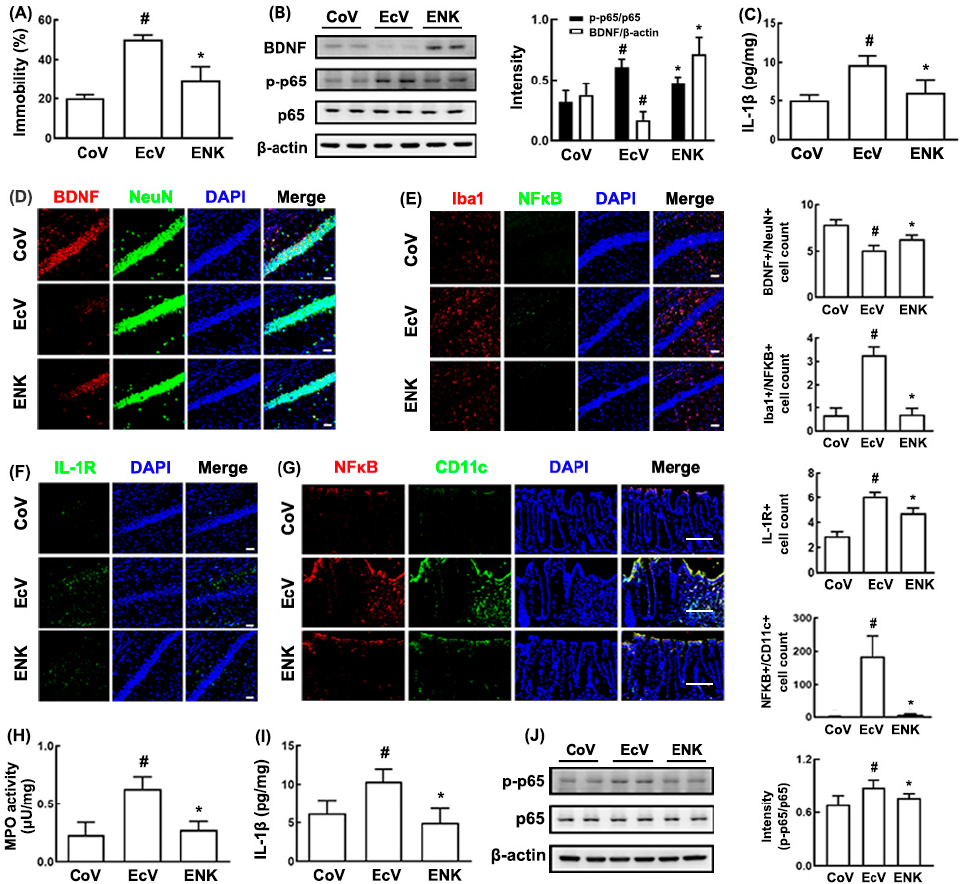
Figure 2. Effect of NK109 on the Escherichia coli K1-induced cognitive impairment and colitis in the germ-free mice. ( A ) Effect on the immobility time in the tail suspension test (TST). ( B ) Effect on the brain-derived neurotropic factor (BDNF) expression and NF- κ B activation in the hippocampus. ( C ) Effect on the IL-1 β level in the hippocampus. Effects on the BDNF + /neuronal nuclei (NeuN) + ( D ), NF- κ B + /Iba1 + ( E ), and IL-1R + cell ( F ) populations in the hippocampus. Effect on the myeloperoxidase (MPO) activity ( G ), IL-1 β expression ( H ), the NF- κ B + /CD11c + cell population ( I ), and NF- κ B activation ( J ) in the colon. Escherichia coli K1-treated (EcV) and K1/NK109-treated (ENK) groups were exposed to K1 (1 × 10 9 CFUs/mouse/day) daily for 5 days and thereafter treated with NK109 (for ENK, 1 × 10 9 CFUs/mouse/day) or the vehicle (for EcV) for 5 days. The control group (CoV) was treated with saline instead of K1 and NK109. Data values were are as mean ± SD ( n = 4). # p < 0.05 vs. CoV. * p < 0.05 vs. EcV. Dapi, 4 ′ , 6-diamidino-2-phenylindole dihydrochloride; Iba1, ionized calcium-binding adapter molecule 1; NF- κ B, nuclear factor- κ B; IL-1R, interleukin 1 receptor; IL-1 β , interleukin 1 β ; CD11c, a type I transmembrane protein.